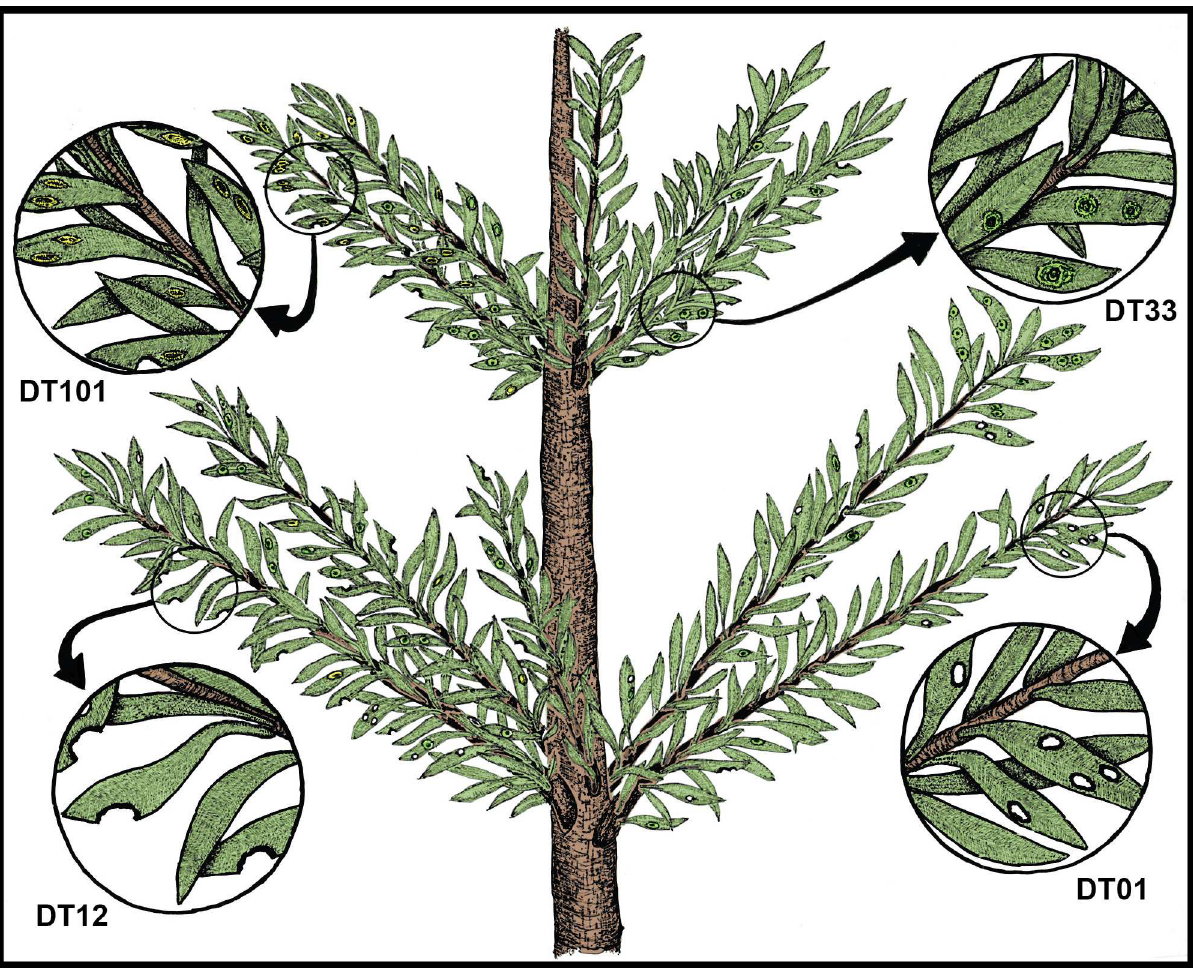
Fig 12. The insect herbivore component community of the conifer Pseudovoltzia liebeana , from the Lopingian (Wuchiapingian) Gro¨den/Val Gardena Flora of northeastern Italy. Four DTs are represented on this host plant, includingcounterclockwise from the lower right: hole feeding of DT01, margin feeding of DT12, oviposition of DT101, and gallingof DT33 (see Fig 5M). Herbivoreinsect culprits responsible for these DTs likely were beetles (DT01), orthopteroids (DT12), sternorrhynchan hemipterans(DT33) and paleodictyopteroids or polyphagan beetles (DT101) [47,149,150,159]. Possible predators of the insect consumers of these herbivores likely included odonatans, heteropterans, neuropterans and